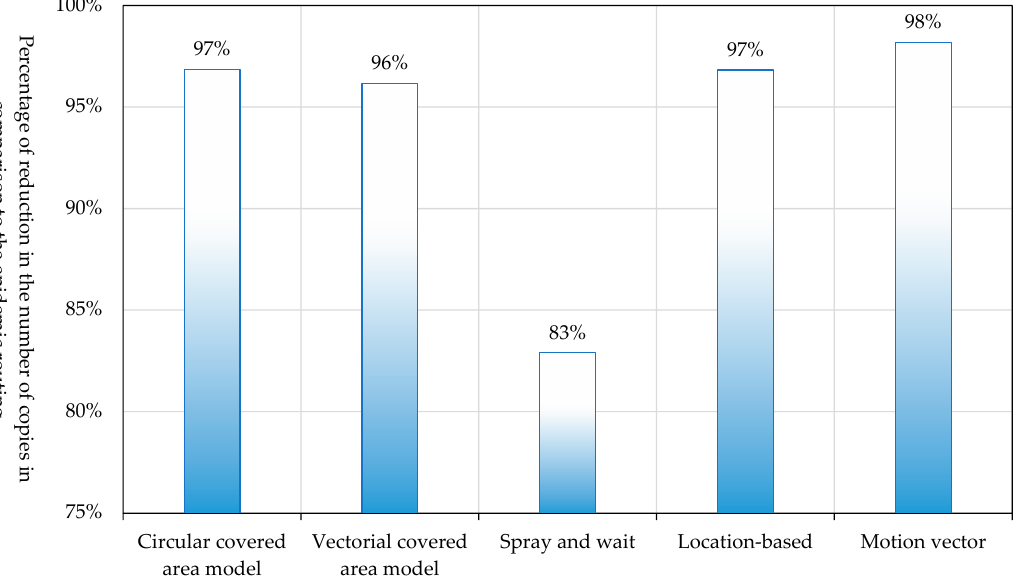
Figure 24. Percentage of the reduction in the number of